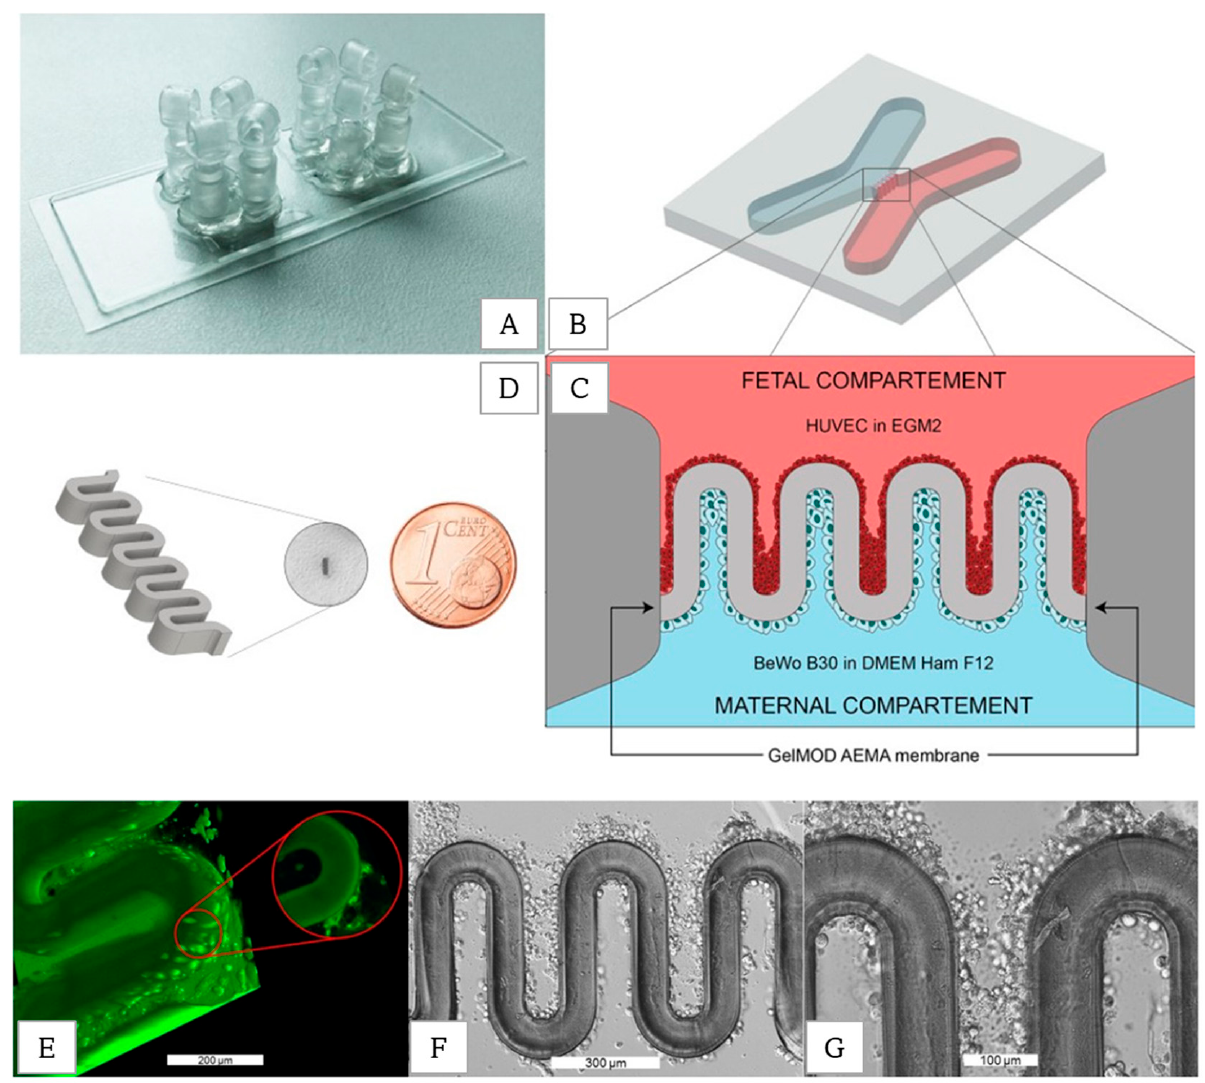
Figure 13. Patterning of ECM biomimetic placenta barrier within a microfluidic device. ( A ) Photo- graph of the microfluidic chip. ( B ) Schematic illustration of the chip and ( C ) placenta barrier. ( D ) Barrier size relative to a cent. ( E ) Fluorescence images show the cell layer formation of HUVEC on the barrier wall. ( F , G ) Cell Layer adhered to the walls. Reprinted and edited with permission granted under CC-BY-NC license. Published by Whioce Publishing Pte. Authors: D. Mandt et al.